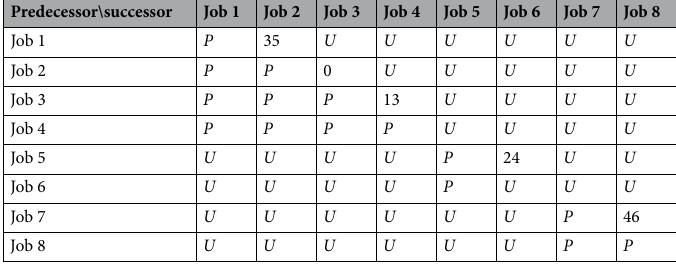
Table 3. Final lag times of the DP constraints table.